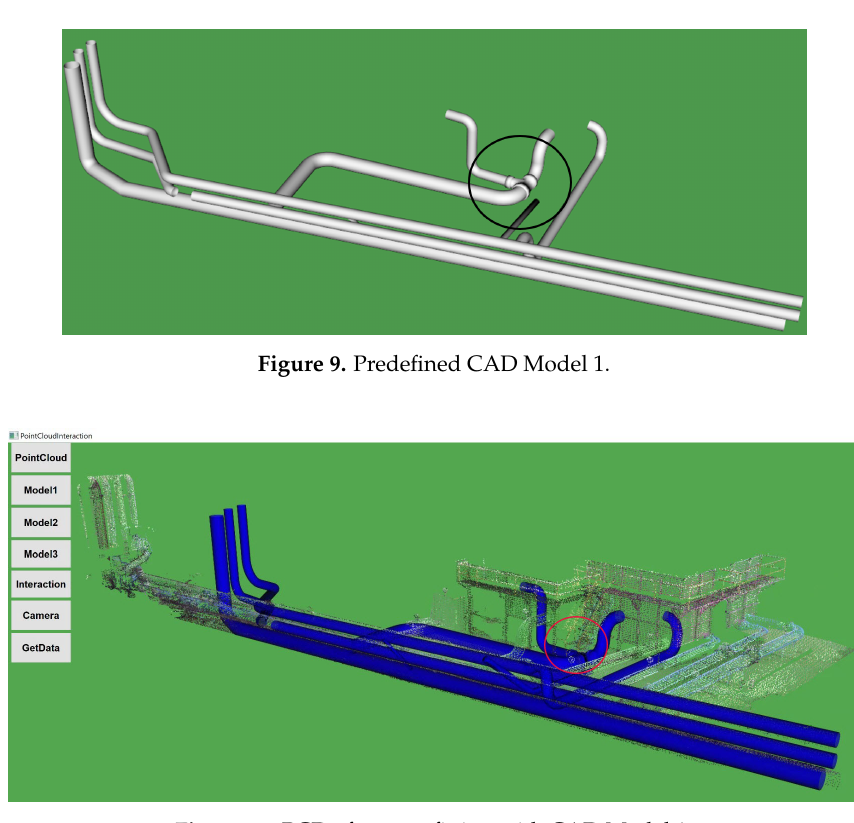
Figure 10. PCD after retrofitting with CAD Model